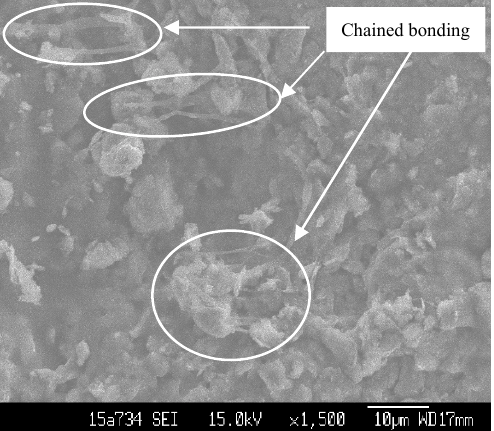
Figure 11. SEM image of the interior of the aggregates.